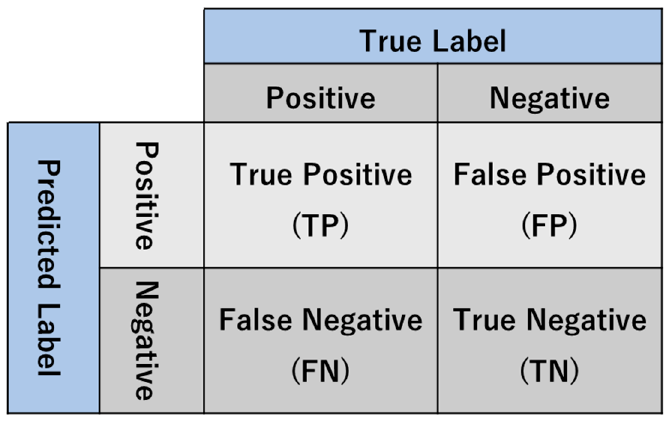
Figure 6. The confusion matrix.